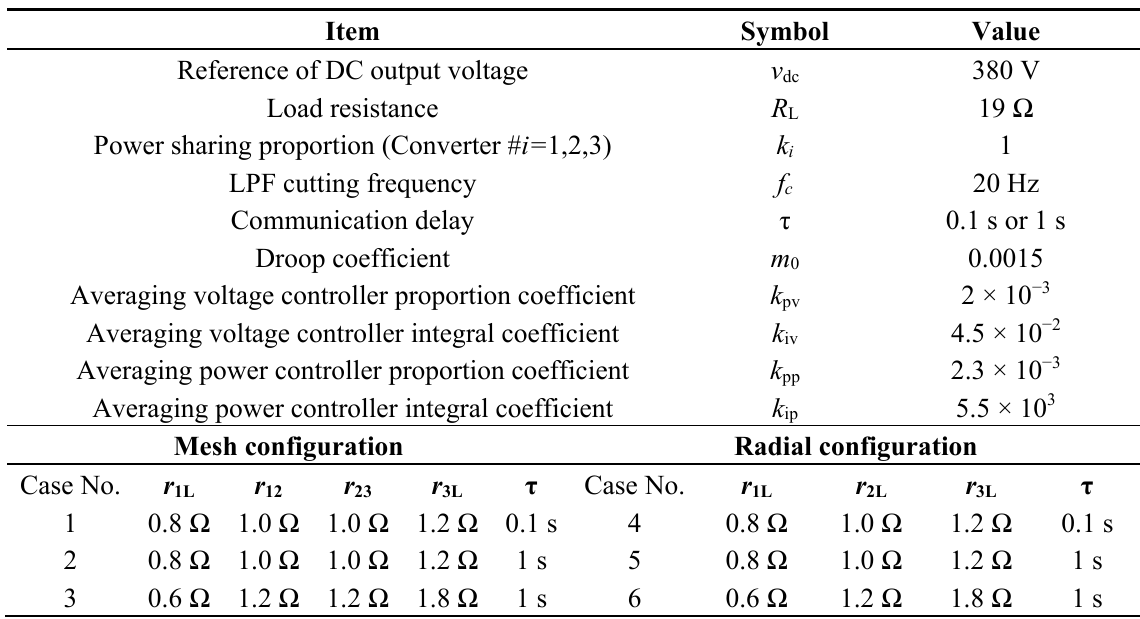
Table 1. DC microgrids system